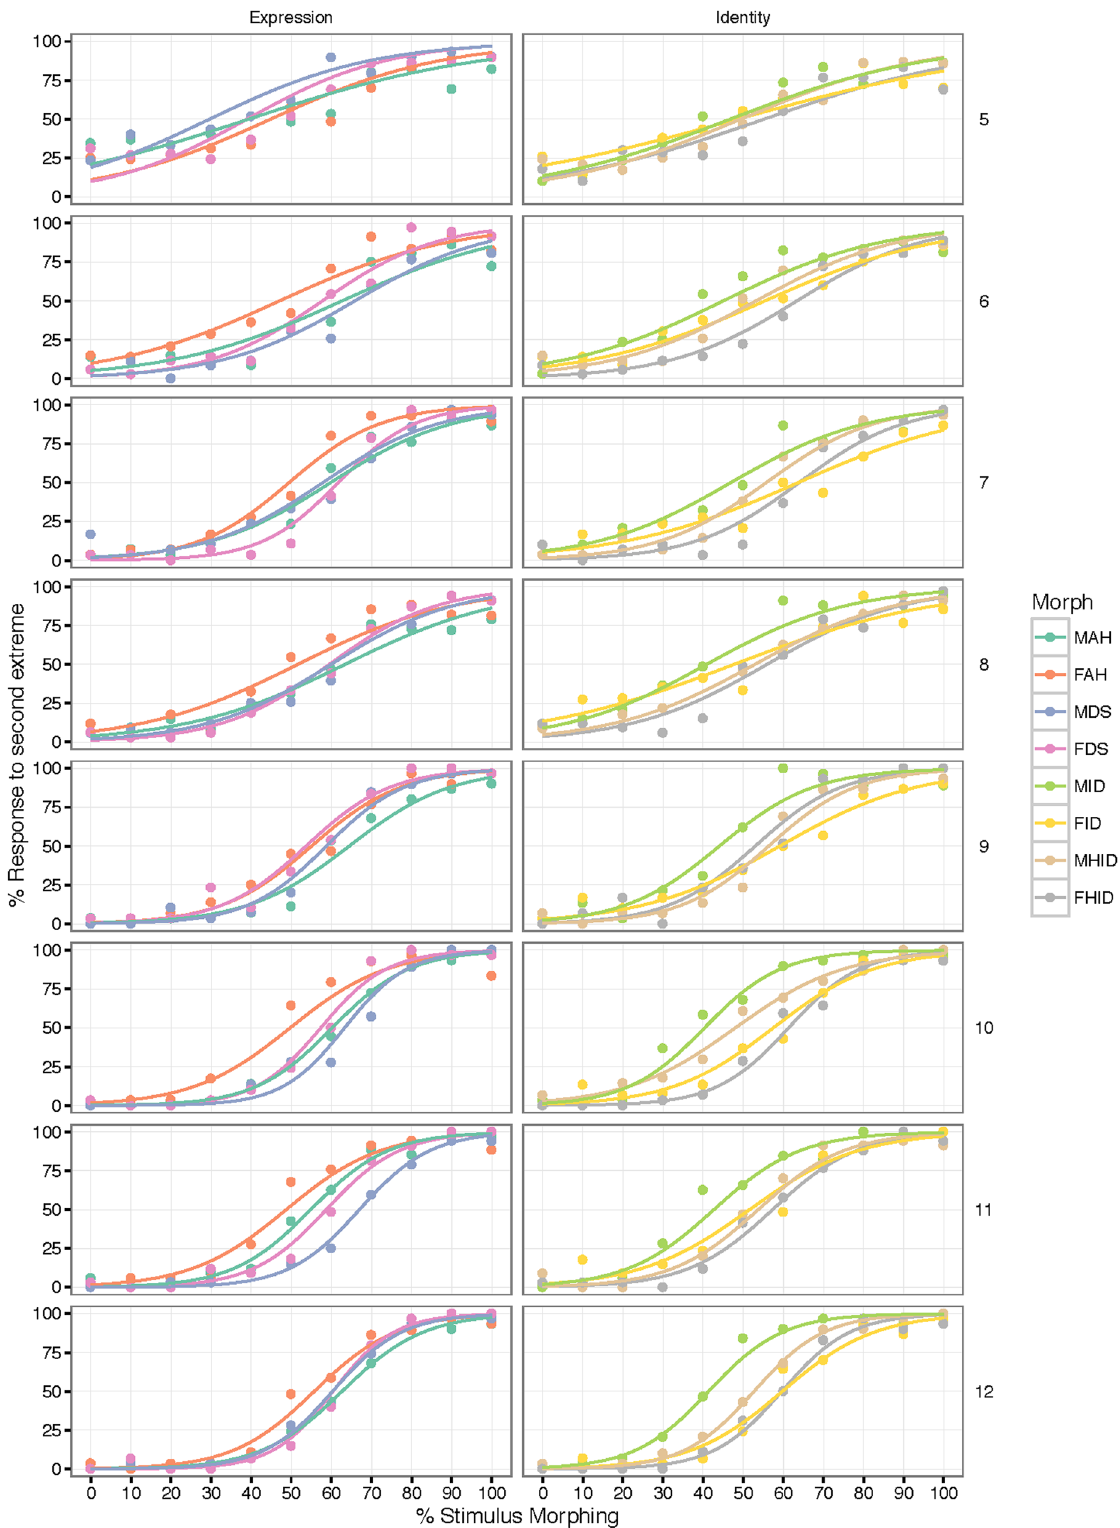
Fig 6. Psychometric curves for identity and expression tasks. Group-level psychometric curves for each age group and morph continuum,dividedaccordingto the task: Expression (left column) and Identity (right column). The x-axis maps the